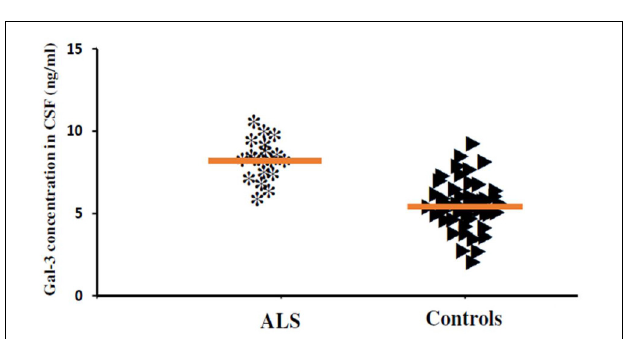
FIGURE 7 | The concentrations of Gal-3 in CSF (ng/mL) of ALS patients and healthy controls. ALS patients showed enhanced Gal-3 concentrations in CSF as compared to the healthy controls (ALS vs. healthy controls [mean ± SD] 7.92 ± 2.56 vs. 5.19 ± 2.23 ng/mL; P = 0.017).